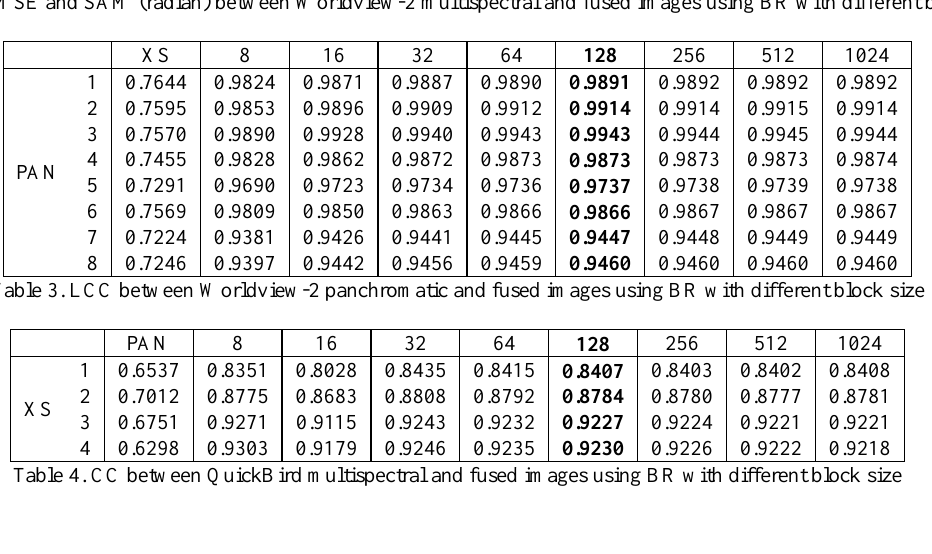
Table 2. RMSE and SAM (radian) between Worldview-2 multispectral and fused images using BR with different block size